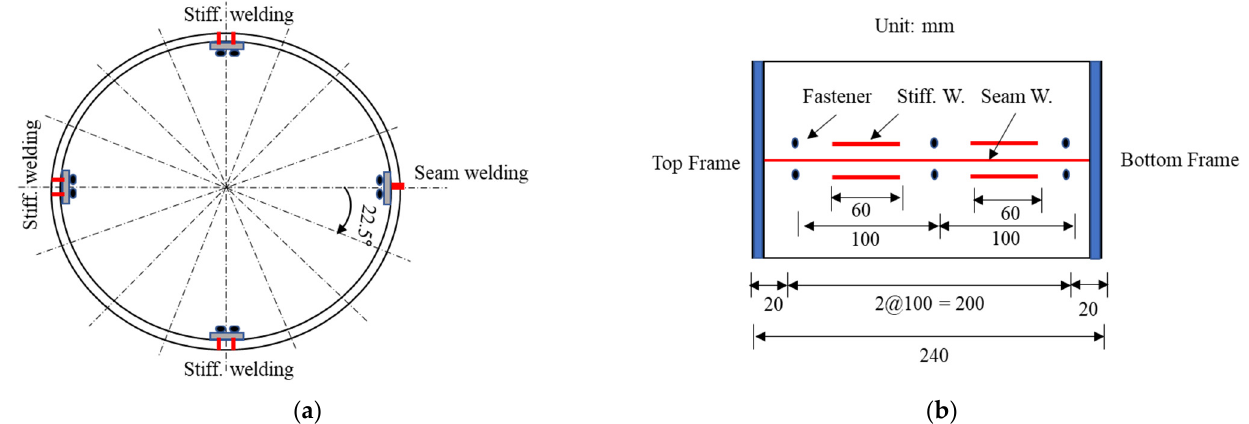
Figure 10. Positions of welding deformation measurement: ( a ) circumferential direction; ( b ) welding length direction.